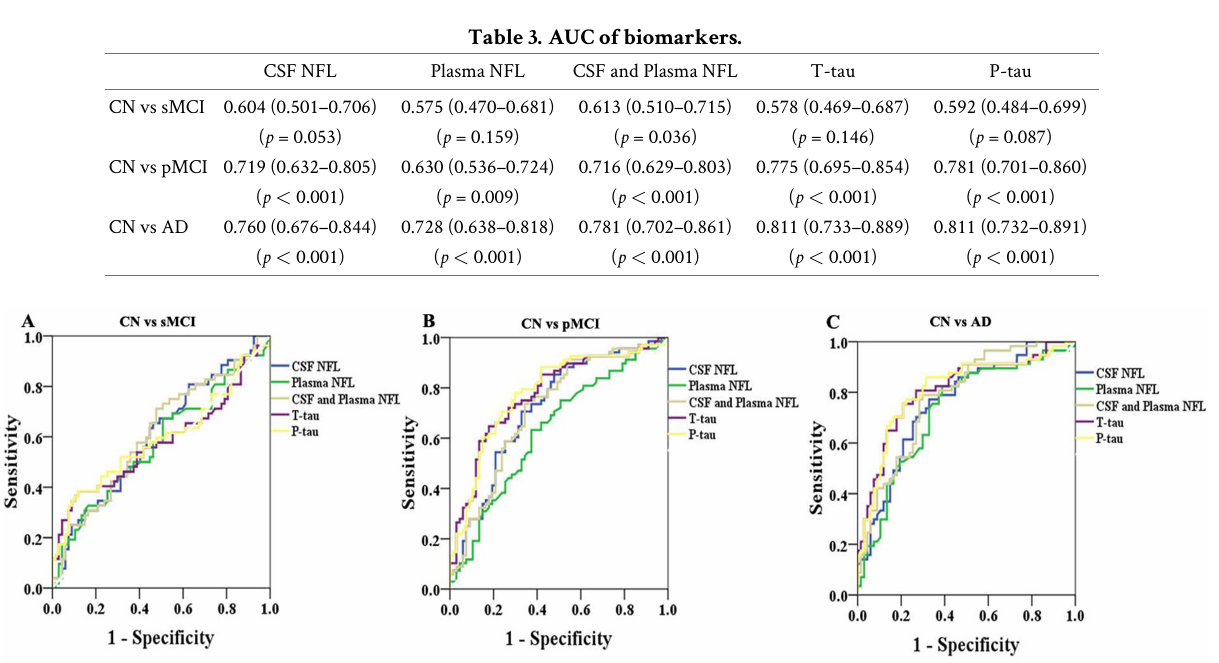
Table 3. AUC of biomarkers.